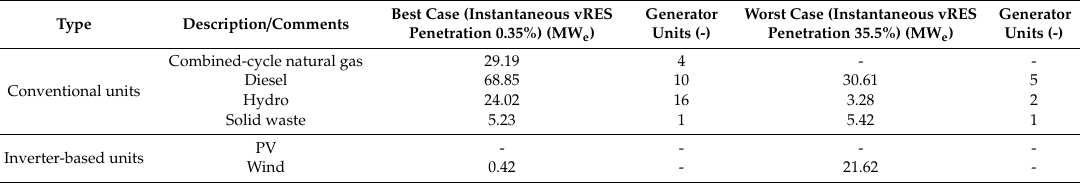
Figure 5. Resulting best and worst cases from the yearly OPF of the future scenario. Table 3. Operating conditions for the best and worst cases of the reference scenario.